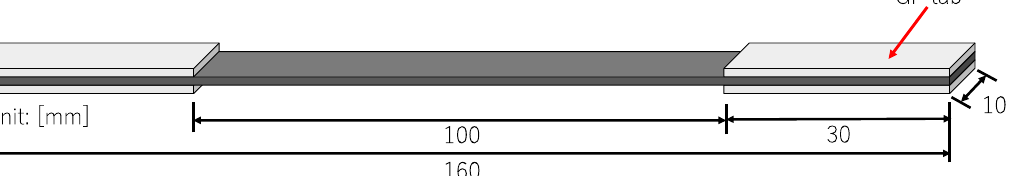
Figure 1. Specimen used for fatigue test.